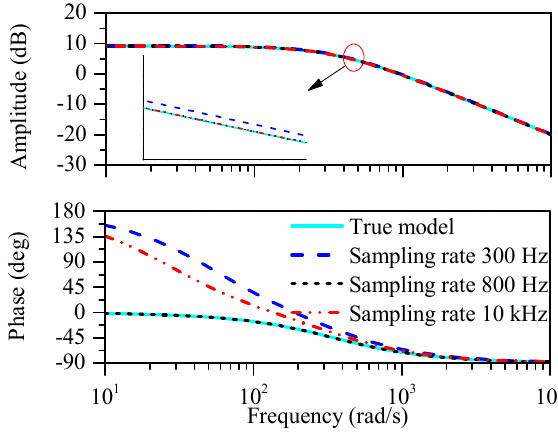
Figure 2. Bode plots of the SRIV identification algorithm with a signal-to-noise ratio of 30 dB.